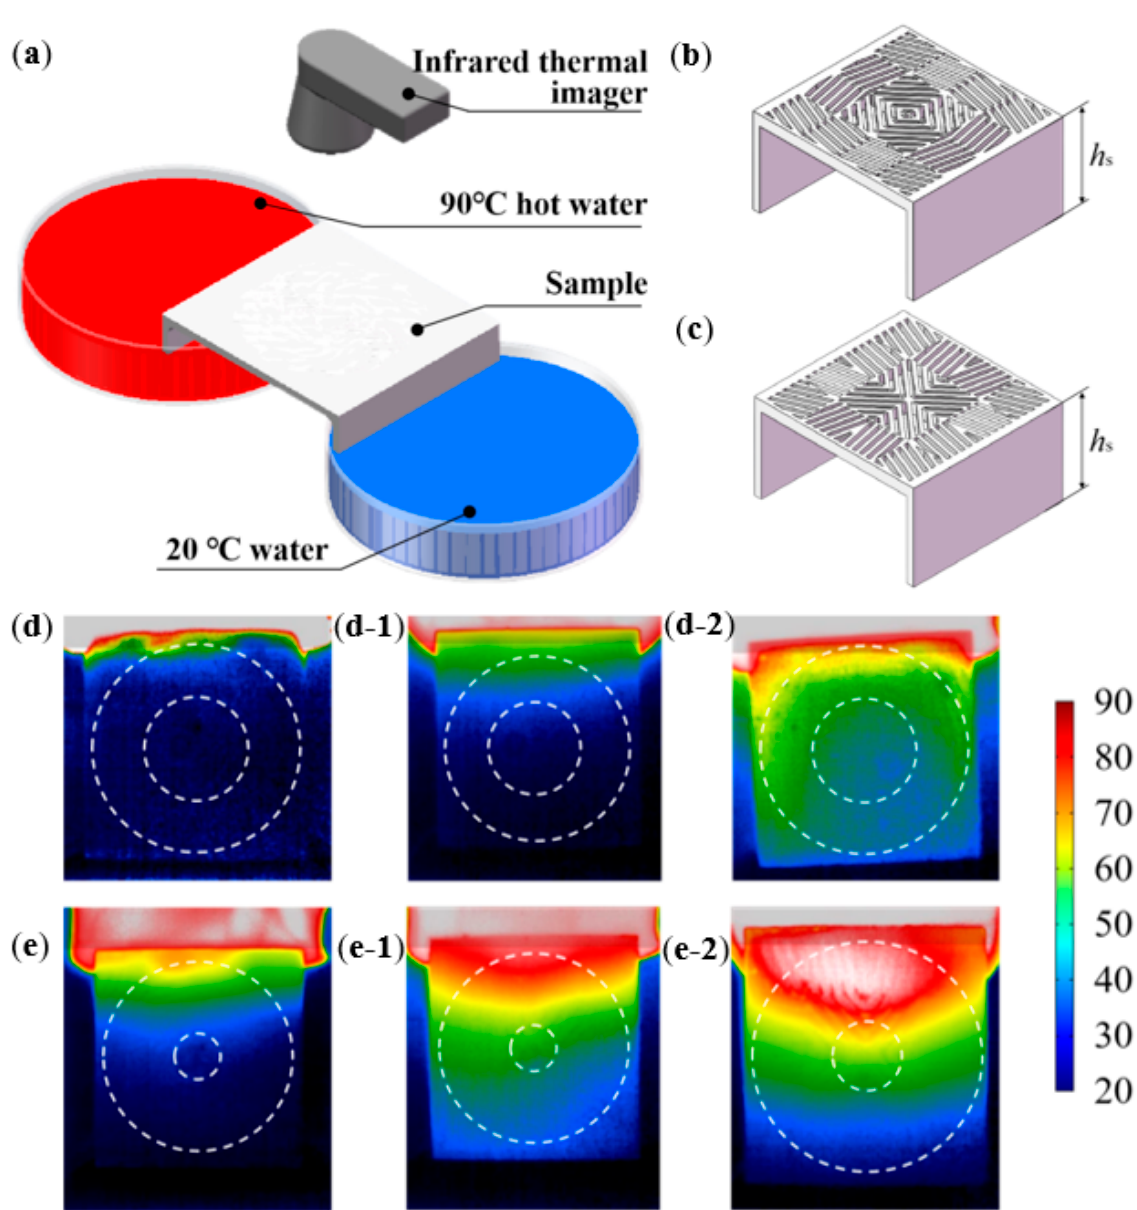
Figure 12. Experimentally measurement ( a ) of the temperature field nephograms of the thermal cloak ( b ) and concentration ( c ) meta ‐ structural devices via the hybrid manufacturing: the temperature field nephograms after measuring for 10 s ( d , e ), 60 s ( d ‐ 1 , e ‐ 1 ), and 180 s ( d ‐ 2 , e ‐ 2 ) on the thermal cloak ( d – d ‐ 2 ) and concentration ( e – e ‐ 2 ) meta ‐ structures.